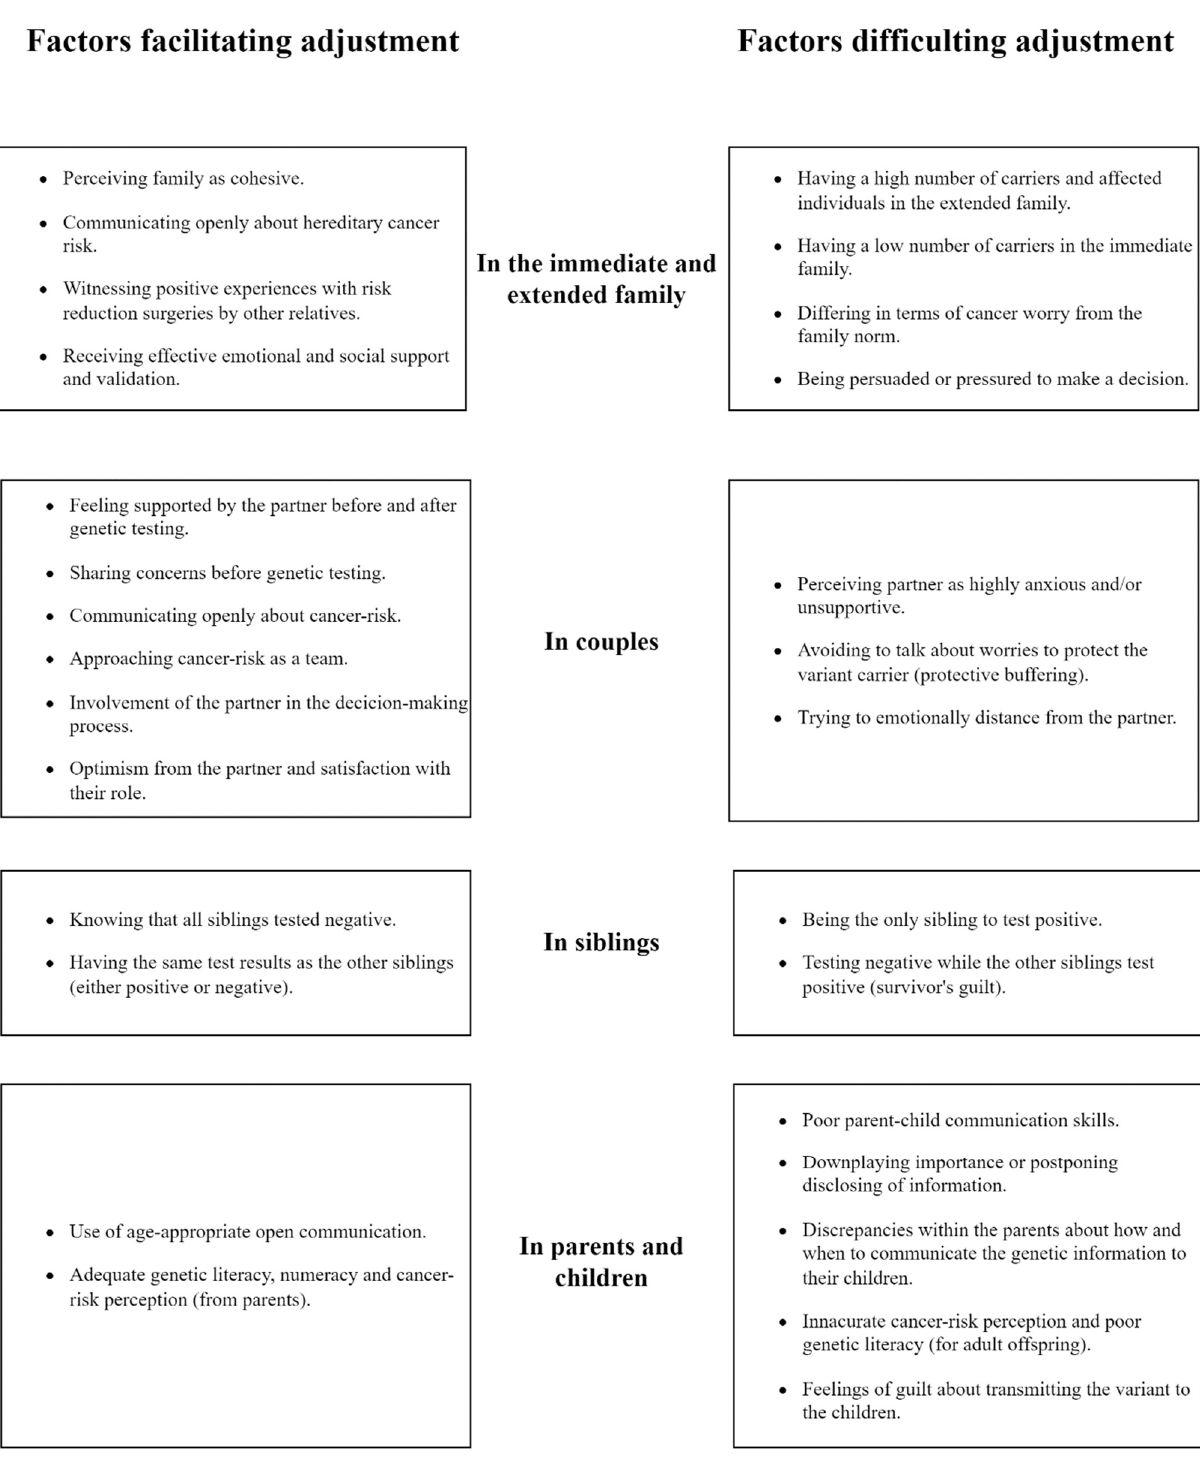
Figure 2. Summary of the factors affecting family adjustment to hereditary cancer syndromes.